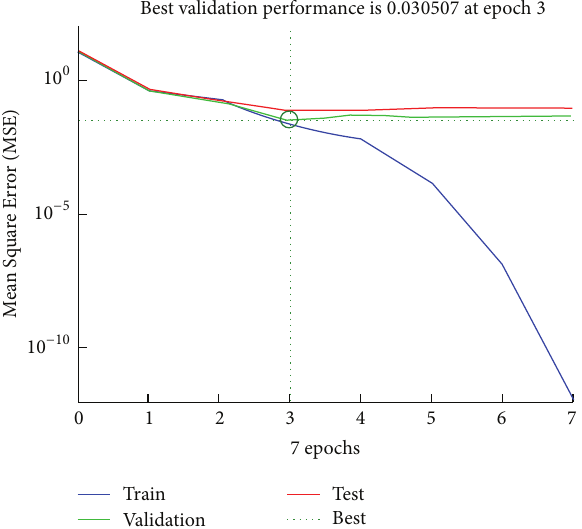
Figure 7: MSE obtained in the training stage.